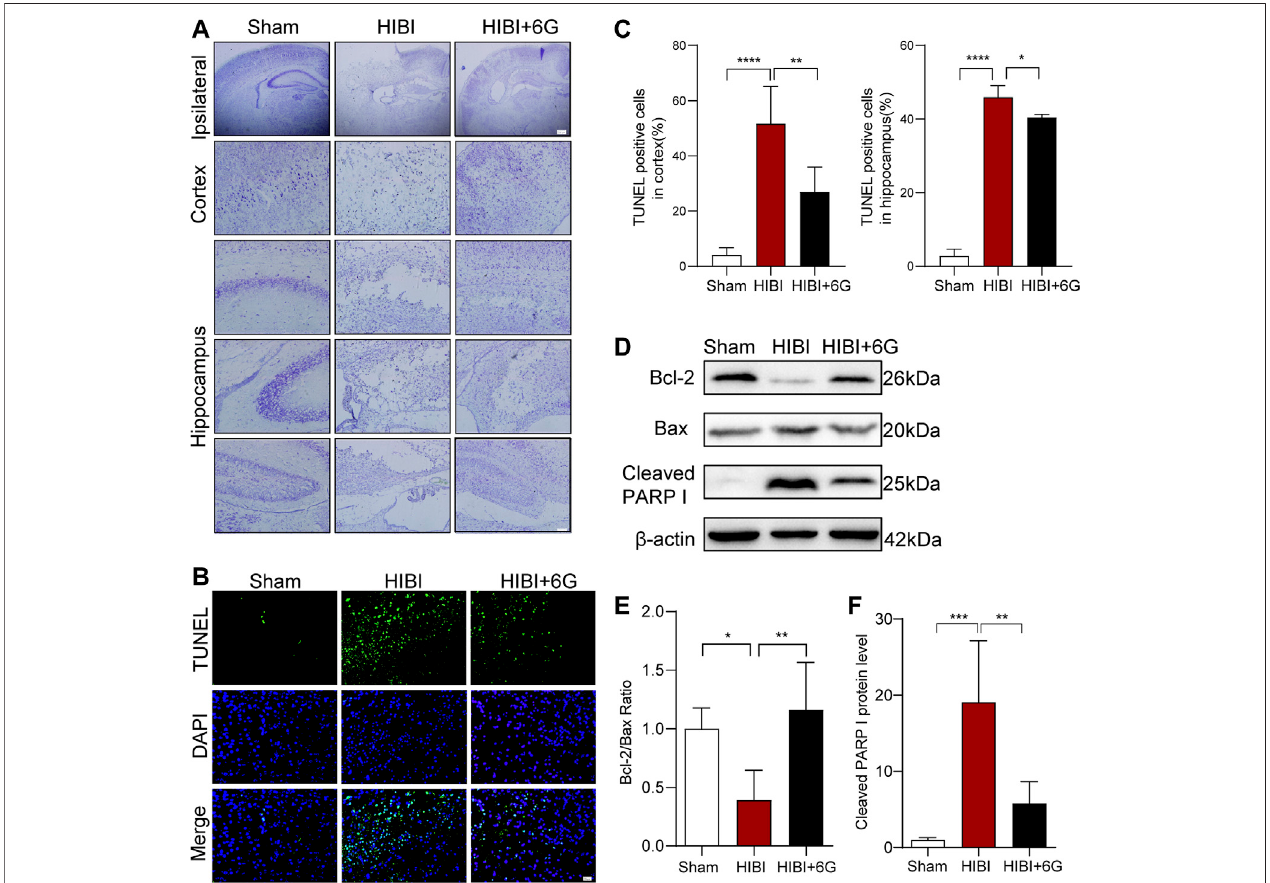
FIGURE 2 | 6-Gingerol alleviates HIBI-induced neuronal apoptosis. (A) Nissl staining of the cortex and hippocampus in each group at 3-day post-HIBI. lpsilateral, scale bar (cid:1) 200 μ m. Cortex and hippocampus, scale bar (cid:1) 50 μ m. (B) RepresentativeTUNEL-stained(green)and DAPI-stained (blue) brainsections ofthecortex 3-day post-HIBI. Scale bar (cid:1) 20 μ m. (C) Quantitative analysis of the percentage of TUNEL-positive cells in the cortex and hippocampus. n (cid:1) 6 per group in A-C. (D – F) Representative western blot images and quanti fi cation of Bcl-2, Bax and Cleaved PARP I expressions at 3-day post- HIBI. n (cid:1) 5 per group. Data represent the mean ± SEM. * p < 0.05, ** p < 0.01, *** p < 0.001, **** p < 0.0001.